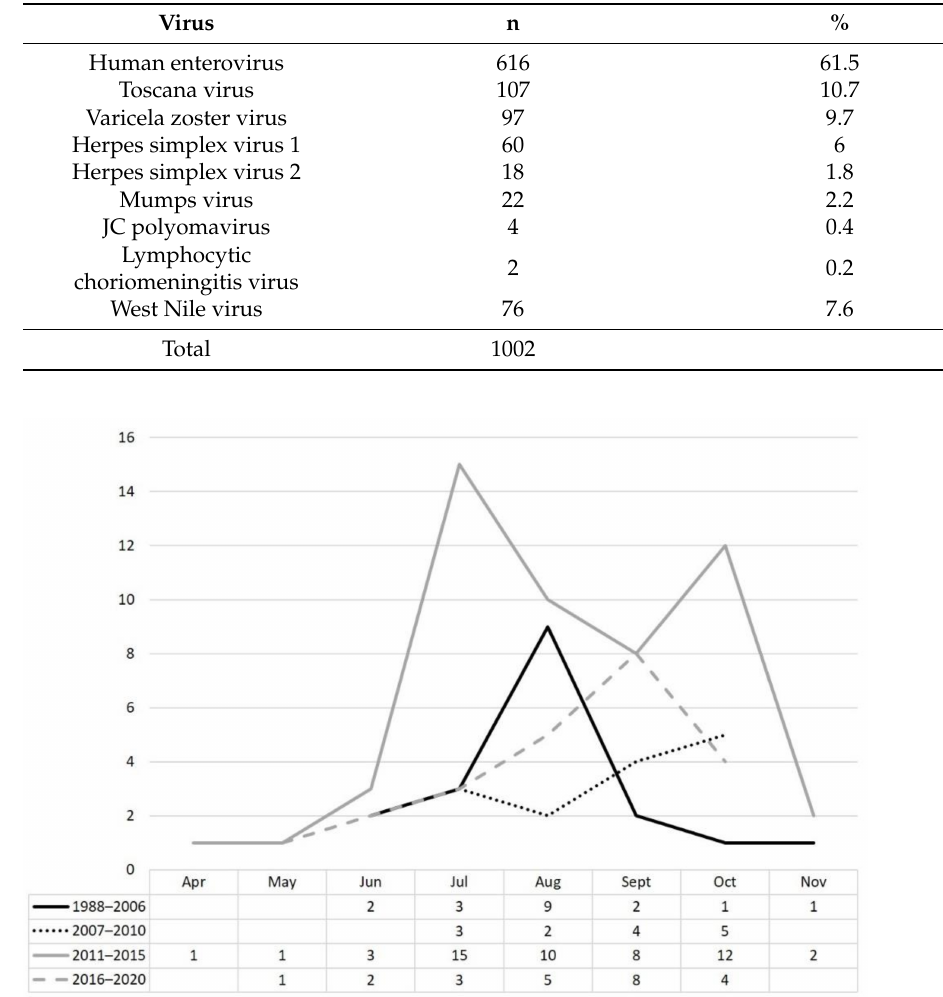
Figure 2. Temporal distribution of TOSV